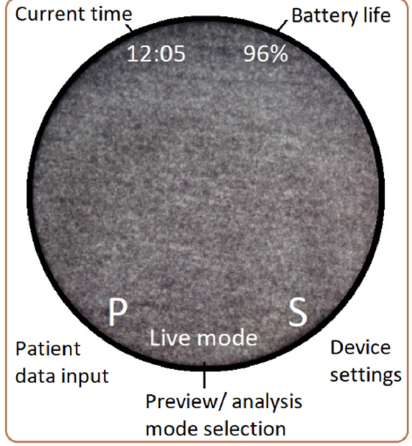
Figure 5. The user’s interface.